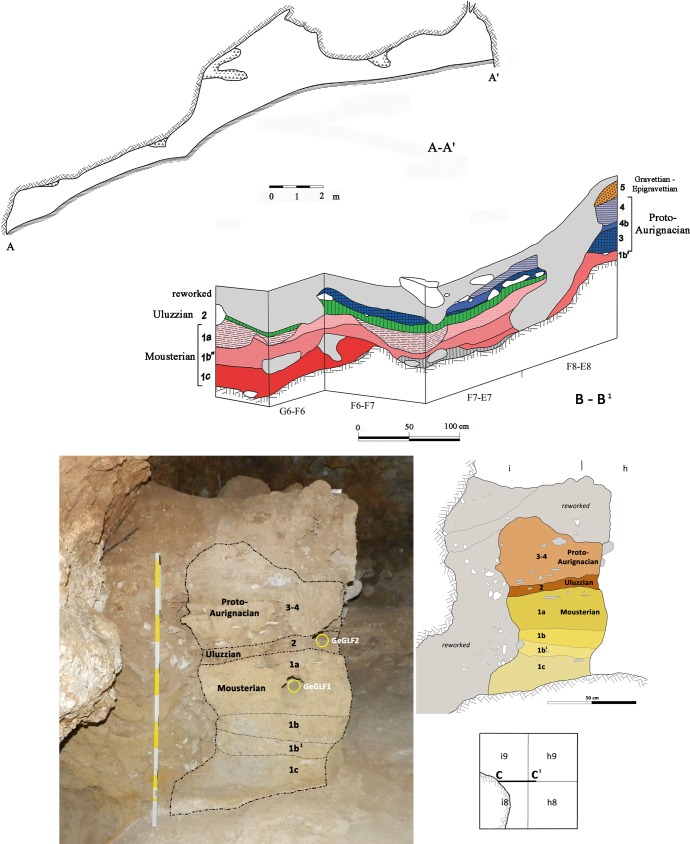
La Fabbrica sections.Section A-A1. The cave floor slopes of about 30 degrees to the west, the ceiling is generally low. Section B-B1 illustrates the sequence of occupations. Section C-C1 shows the location of the two OSL samples taken in intact deposits in 2012.